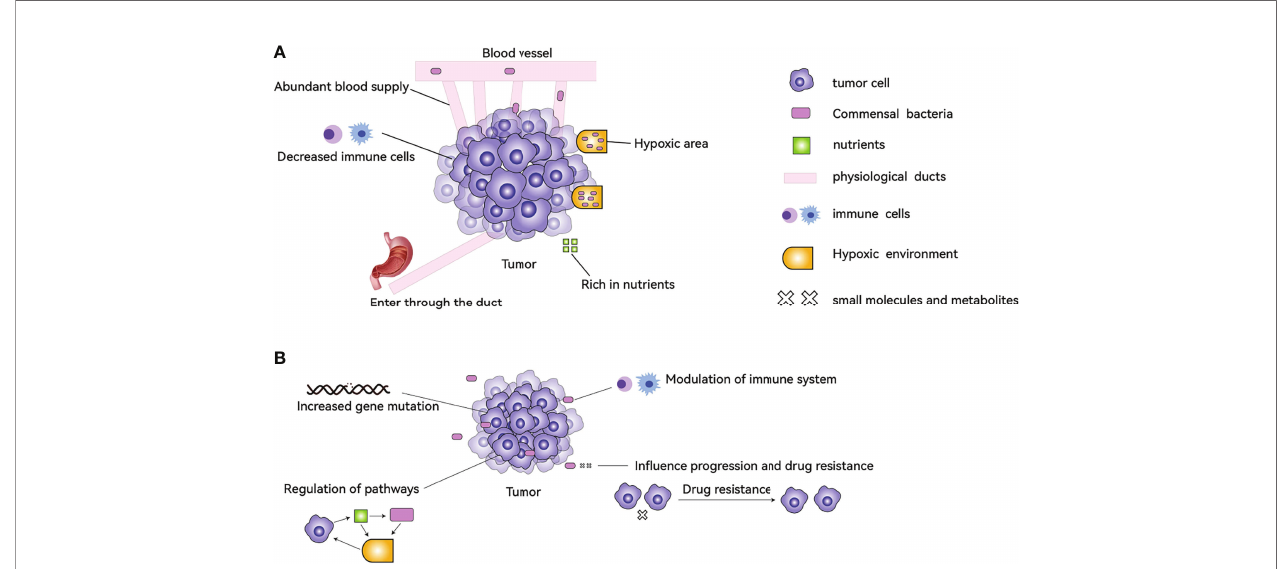
FIGURE 1 | The causes of TM formation in tumors and its effects on tumors. (A) The abundant blood supply, hypoxic environment, abundant nutrients, and reduced immune cells help the bacteria to colonize the tumor tissue. Bacteria can also enter through the ducts, for example, from the duodenum into the pancreas. (B) TM can affect tumor characteristics by increasing gene mutations, regulating the function of immune cells, modulating signaling pathways, and in fl uencing drug